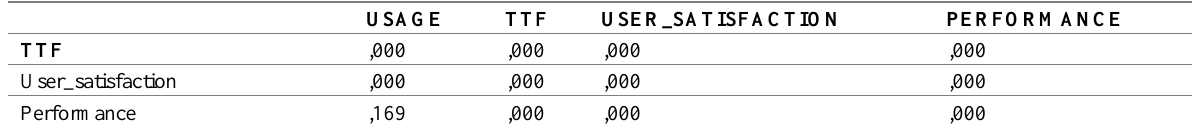
Table 4: Standardized Indirect